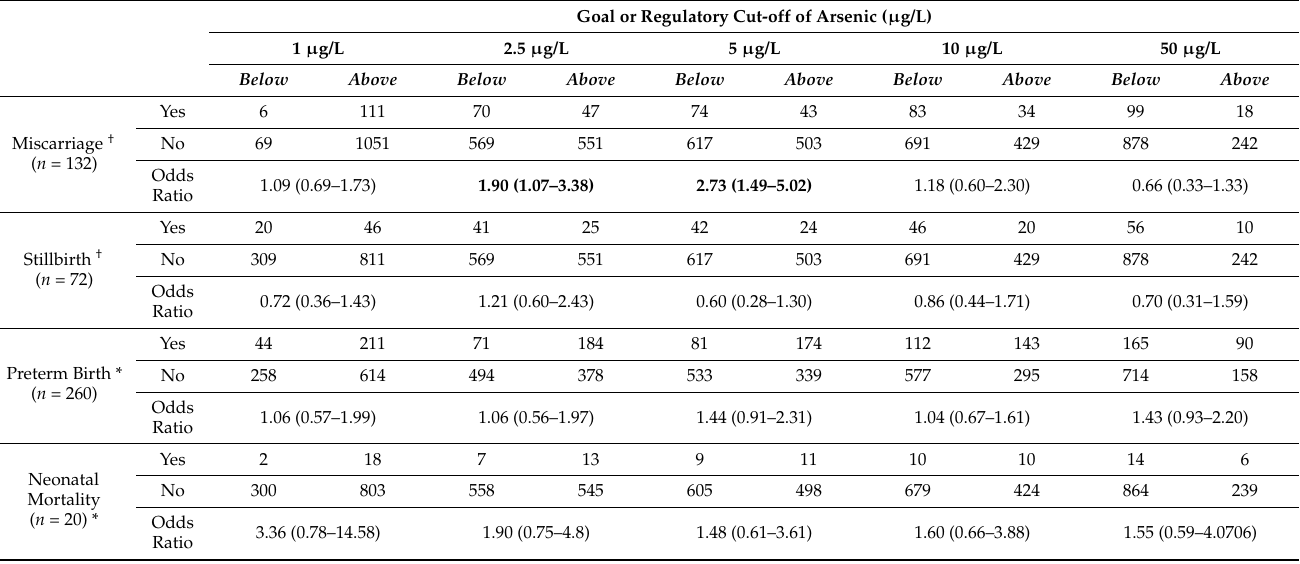
Table 2. Odds of adverse pregnancy risk based on cut-off regulatory/recommendation values for drinking water arsenic for women in